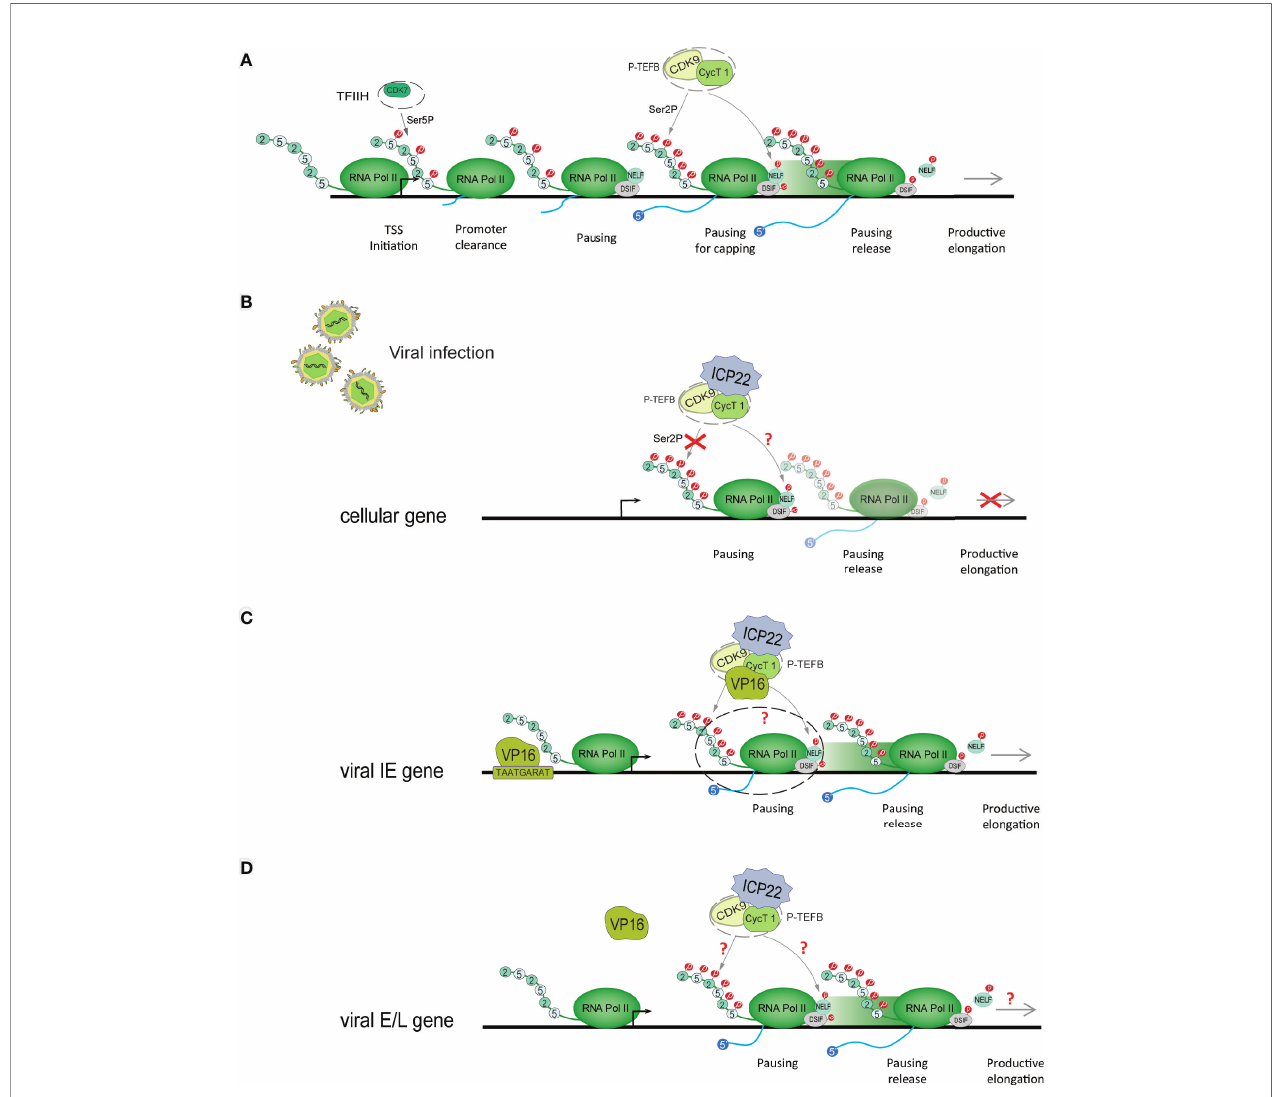
FIGURE 3 | HSV-1 ICP22 changes the phosphorylation state of Pol II to regulate transcriptional extension. (A) Schematic diagram of the Pol II-mediated transcription process. When PIC is assembled, it stimulates the CDK7 subunit of TFIIH to phosphorylate CTD Ser-5. Immediately, Pol II breaks away from the gene promoter, and after the fi rst 30-50 nucleotides are transcribed, it pauses at approximately 30-50 nucleotides downstream of the transcription start site (TSS). To overcome ppp, activated P-TEFB is recruited to the gene locus. Activated P-TEFb phosphorylates Pol II CTD Ser-2, NELF and DSIF and initiates Pol II ’ s ef fi cient transcription extension mode. (B) HSV-1 ICP22 directly interacts with CDK9 and inhibits CDK9 enzyme activity, thereby inhibiting Ser-2 phosphorylation and inhibiting the transcription of cellular genes. (C) ICP22 regulates the IE gene. VP16 recognizes and binds to the core motif TAATGARAT near the IE gene promoter to activate IE gene expression. VP16 may release the transcriptional inhibition of the IE gene by ICP22 by interacting with P-TEFb. (D) It is unclear how HSV-1 blocks the inhibitory effect of ICP22 on E and L